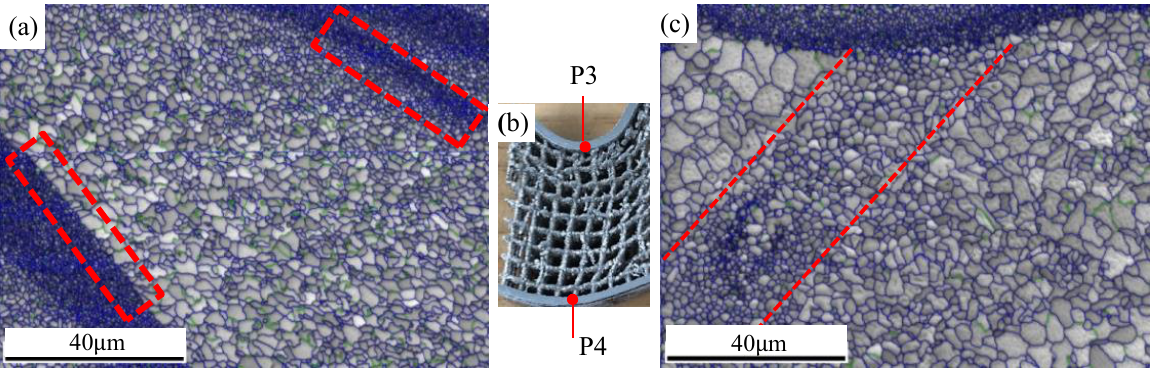
Figure 13. Grain distribution in different spots after bending: ( a ) characteristic regions of grain distributioin; ( b ) the detected spots; ( c ) crushed grains during bending. The grain orientation variations of the characteristic positions after bending are reg- ulated as follows: The (001) grain orientation of the lower end plate is more chaotic than that of the upper one (Figure 14). The original orientation is weak due to the low Hall–Pitch coefficient for the aluminum matrix [4]. The texture of the bent upper end plate on width direction is stronger than that of the lower one. This phenomenon may be due to the deformation state of compressing first and stretching afterwards in the upper end plate, which causes the (001) crystal plane to rotate towards the transversal direction, namely more parallel to the width direction.